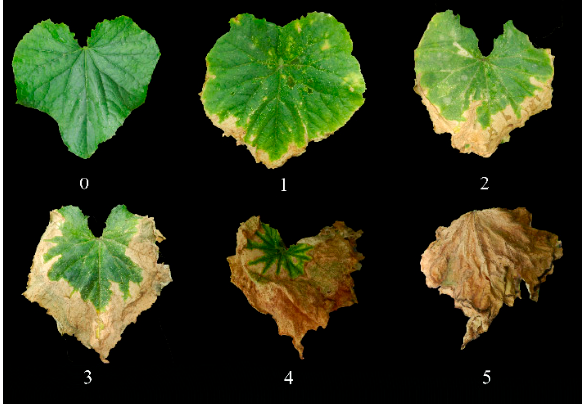
Figure 1. Phenotypic characterization of heat tolerance in cucumber adult plant: 0 = no symptoms on the 8th to 10th leaves; 1 = only edges of the 8th to 10th leaves were dried; 2 = 1/3 of the 8th to 10th leaves were dried; 3 = 1/2 of the 8th to 10th leaves were dried; 4 = more than 2/3 of the 8th to 10th leaves were dried; 5 = all of the 8th to 10th leaves were dried.